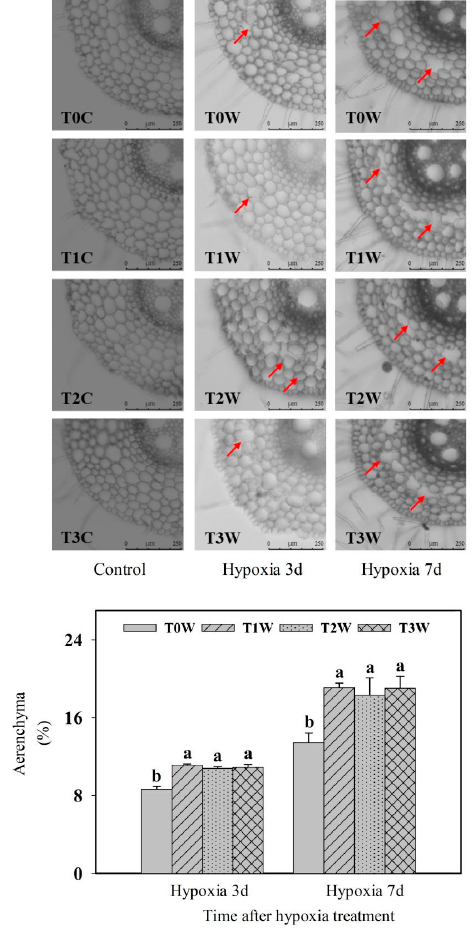
Figure 7. Effects of waterlogging priming on aerenchyma at the position 40mm from the root tip of offspring plants grown under hypoxia stress for 3 d and 7 d in wheat seedling. Note: The arrow indicates the position of the aerenchyma cavity. T0C, no priming + no offspring hypoxia stress; T0W, no priming + offspring hypoxia stress; T1C, one-generation priming + no offspring hypoxia stress; T1W, one-generation priming + offspring hypoxia stress; T2C, two-generation priming + no offspring hypoxia stress; T2W, two-generation priming + offspring hypoxia stress; T3C, three-generation priming + no offspring hypoxia stress; T3W, three-generation priming + offspring hypoxia stress. Data are means ± SE (n = 3). Different lowercase letters indicate the significant difference at p < 0.05 level.